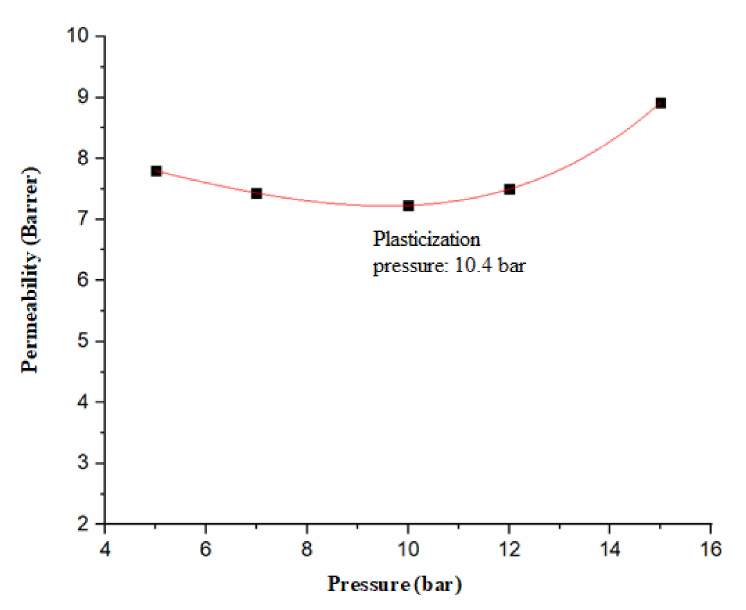
Figure 8. Effect of CO 2 pressure on